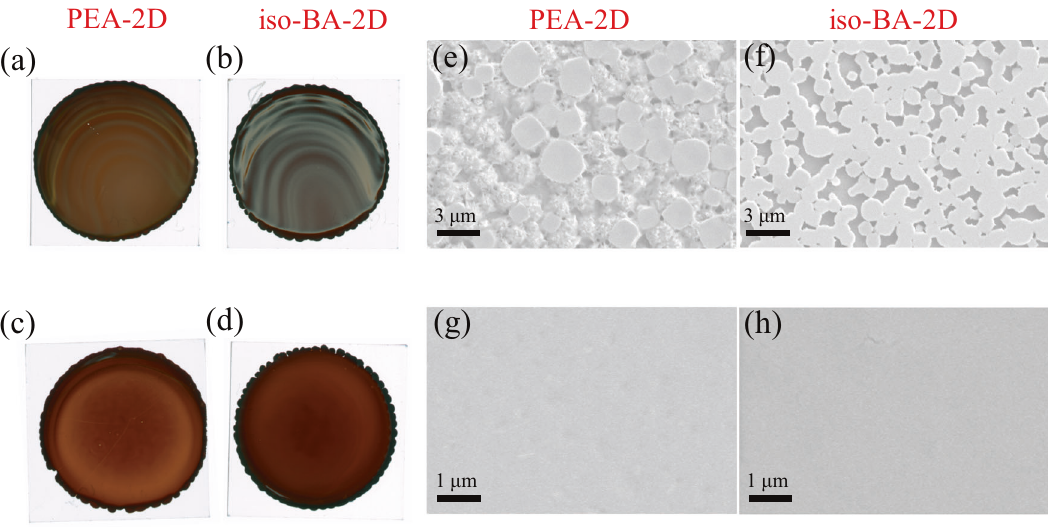
Fig. 2 Morphology of the drop-cast fi lms prepared using different cations and conditions. Photographic images of PEA-2D and iso-BA-2D perovskite fi lms prepared by natural drying ( a , b ) and N 2 blow-drying ( c , d ); SEM images of PEA-2D and iso-BA-2D perovskite and N 2 blow-drying ( g , h